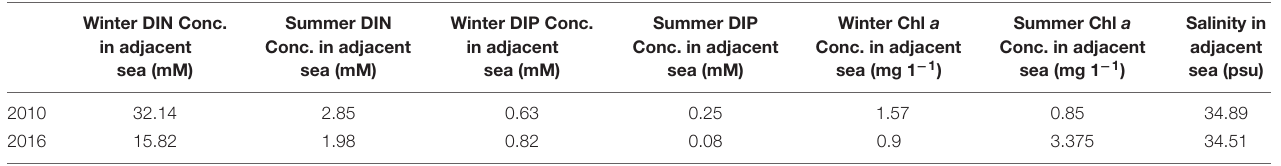
TABLE 3 | Tidal boundary concentrations of DIN, DIP, chlorophyll a and salinity for 2010 and 2016 based on the EPA monitoring data collected at station AR120 at the outer edge of inner Courtmacsherry Bay; values determine the extrema of a standard tidal boundary forcing curve which provides separate tidal boundary concentration values for each day.